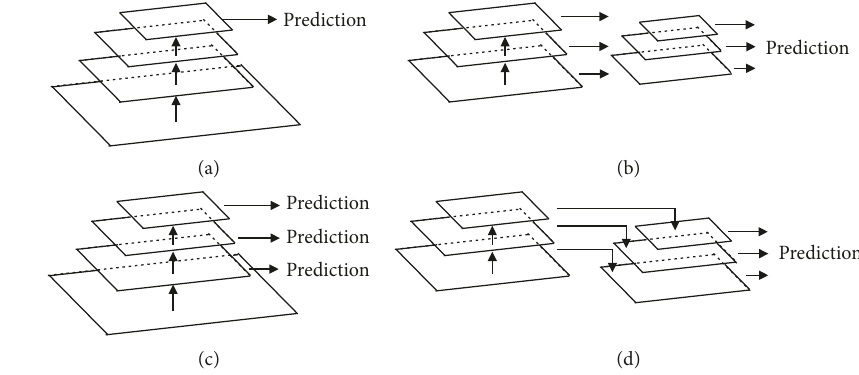
Figure 3: Classification of the pyramid